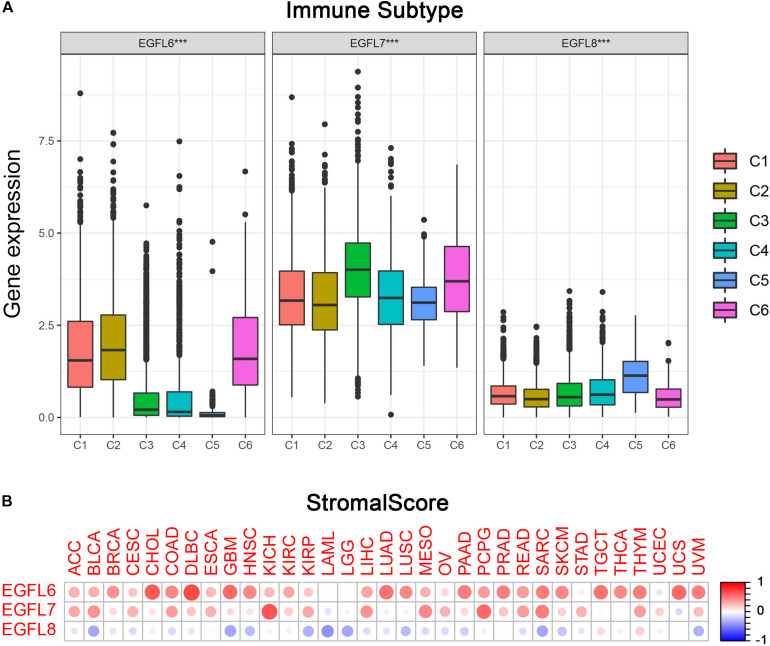
Association of EGFL6/7/8 gene expression with tumor microenvironment factors. (A) Association of EGFL6/7/8 gene expression with immune infiltrate subtypes across all the cancer types (P < 0.05) tested with ANOVA. (B) Correlation matrix plots showing the association between EGFL6/7/8 gene expression and stromal scores of 33 different cancer types based on ESTIMATE algorithm. Spearman’s correlation was used for testing. The size of the dots stands for the absolute value of the correlation coefficients. The bigger the size is, the higher the correlation would be (higher absolute correlation coefficient). This also applies to Figures 4A,B, as well as Supplementary Figures S4A,B.